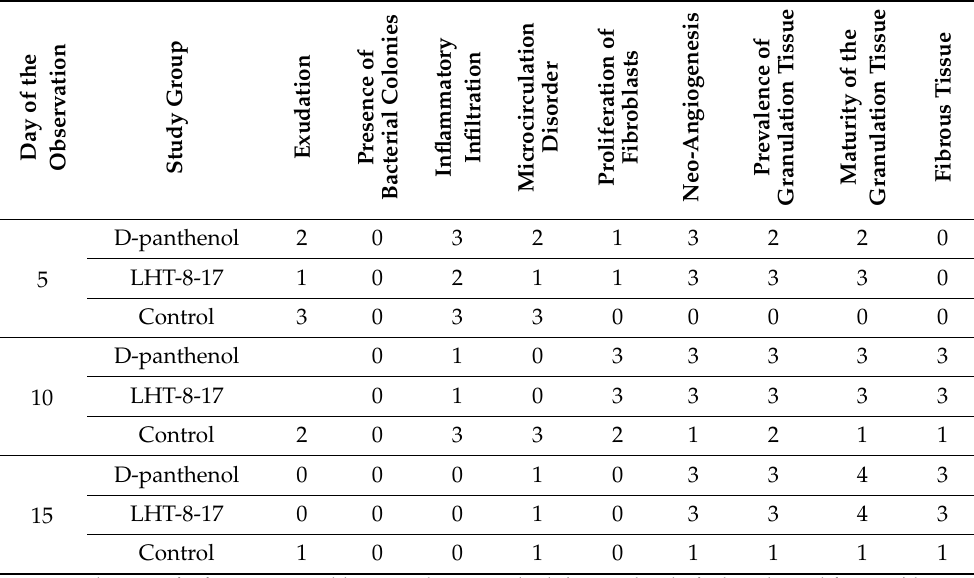
Table A1. Histological scoring of T2D diabetic wounds topically treated with LHT-8-17 at different timepoints of the healing process according to